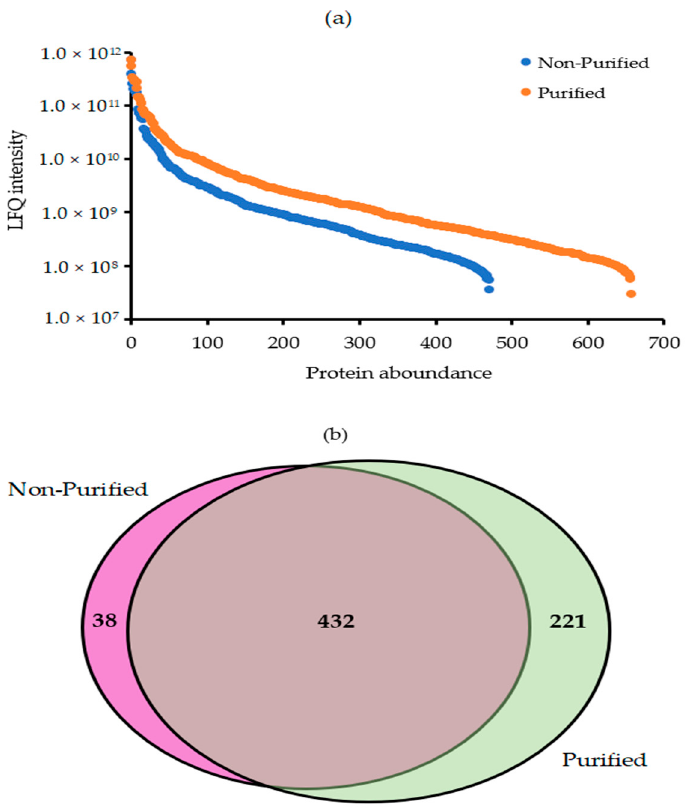
Figure 4. ( a ) The ranked protein abundance plots for the purified and non-purified material; ( b ) the Venn diagram summarizes the groupings of the identified proteins in the S. subterranea proteome database. LFQ: label-free